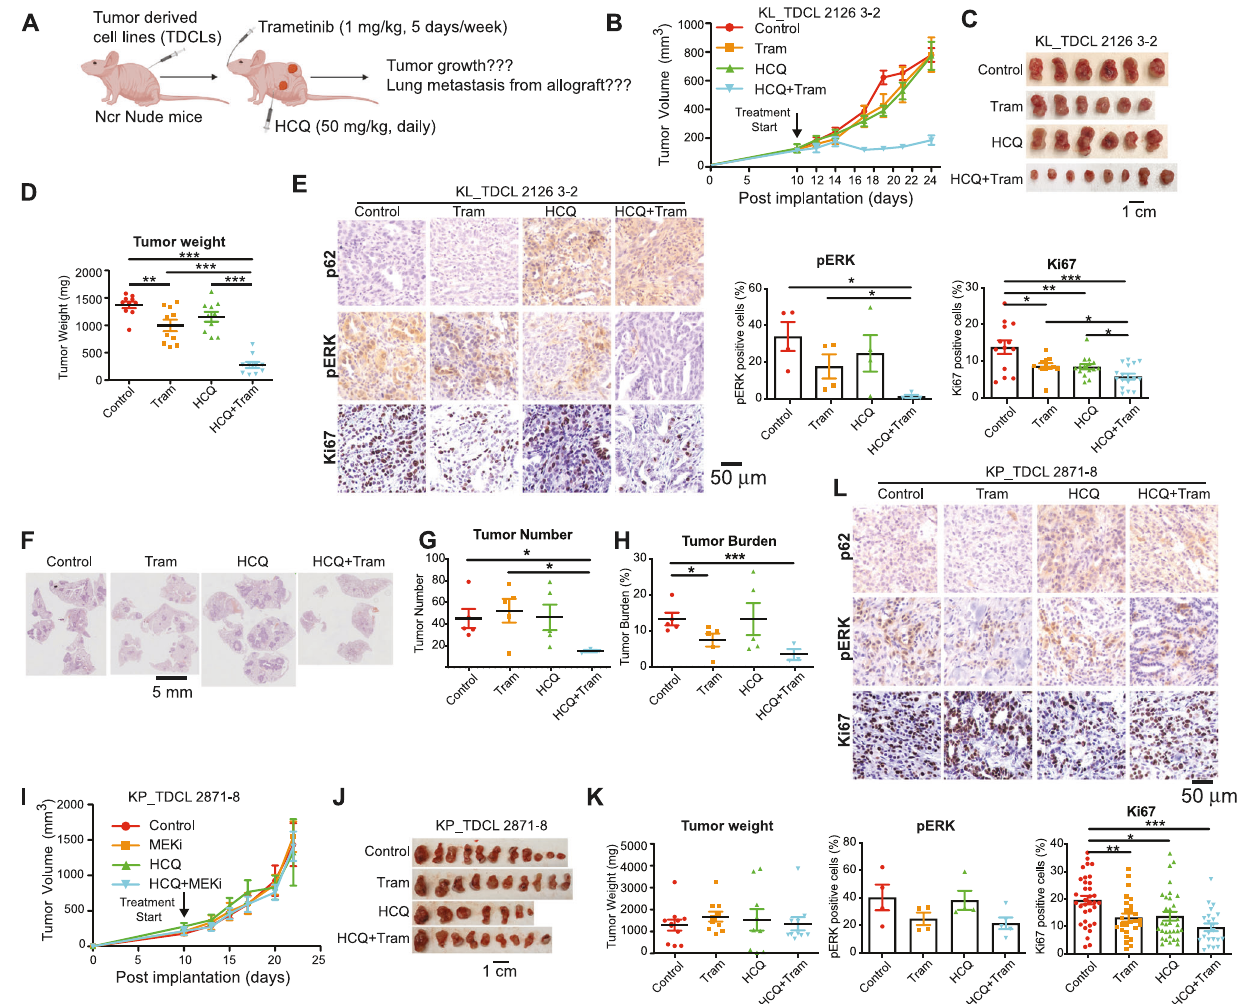
Fig. 2 Combination of HCQ and Trametinib inhibited the growth of established KL allograft tumors, and not KP allograft tumors. A Scheme of an allograft mouse model in immunode fi cient Ncr nude mice treated with vehicle control, HCQ (50 mg/kg, daily, I.P.), Trametinib (1 mg/kg, 5 days/week, oral gavage), or the combination. B Graph of KL allograft tumor growth in Ncr nude mice treated with vehicle control, HCQ, Trametinib, or the combination. C Gross pathology of KL allograft tumors in Ncr nude mice treated with vehicle control, HCQ,